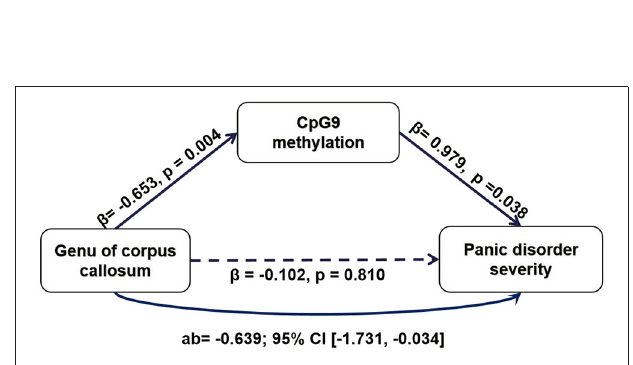
FIGURE 4 | The mediating role of CpG9 methylation of NOS1 in the relationship between the mean diffusivity (MD) values of the genu the corpus callosum (CC) and the Panic Disorder Severity Scale (PDSS)